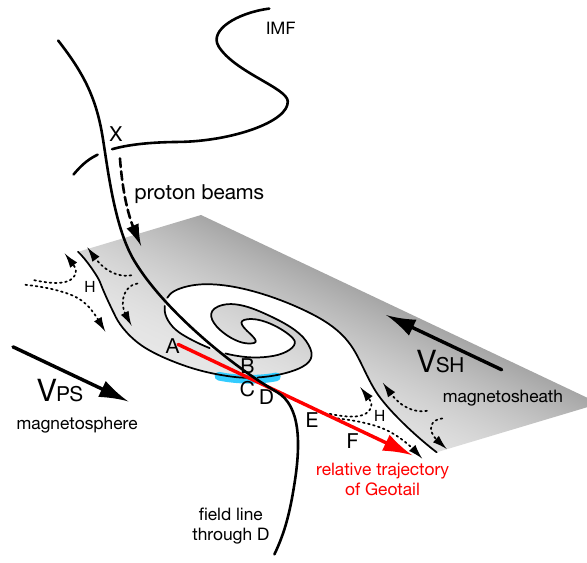
Fig. 13. A schematic picture of the relative trajectory of the space- craft in the frame of reference moving with the vortices. A candi- date for the trajectory is presented as a red arrow on which rough locations of regions (A–F) are appended. The magnetic field line that passes through region (D) is depicted. The symbol “X” and “H” in the figure show candidates for reconnection region and the hyperbolic point, respectively. A blue-colored region between re- gions (B) and (C) corresponds to the observed current